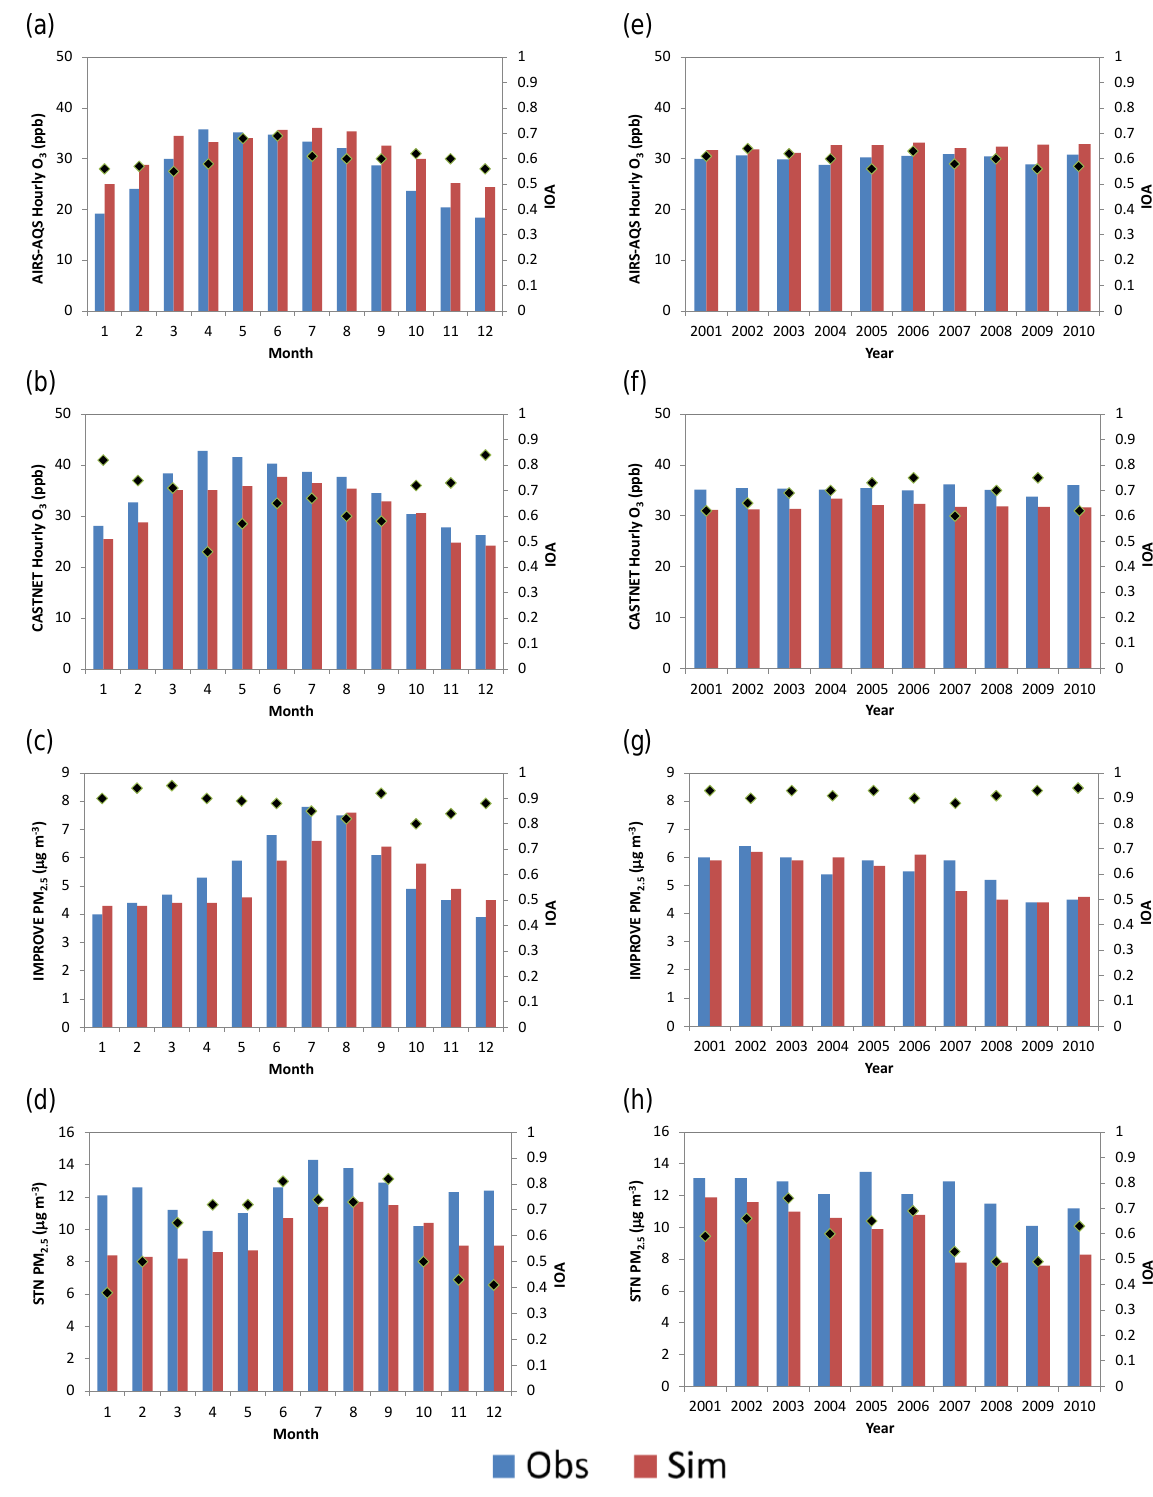
Figure 4. Time series of 10-year averaged monthly mean observations (blue) vs. simulations (red) for (a) O 3 against AQS data, (b) O 3 against CASTNET data, (c) PM 2 . 5 against IMPROVE, and (d) PM 2 . 5 against STN, and annual averages for (e) O 3 against AQS data, (f) O 3 against CASTNET data, (g) PM 2 . 5 against IMPROVE, and (h) PM 2 . 5 against STN. IOA statistics (black diamonds) are also provided on the secondary y axes in panels (a) – (h)